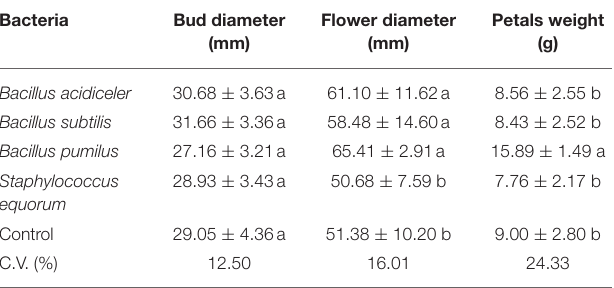
TABLE 3 | Effect of growth-promoting bacteria on the bud diameter, flower diameter and weight of rose petals of the cultivar Black Prince. Bacteria